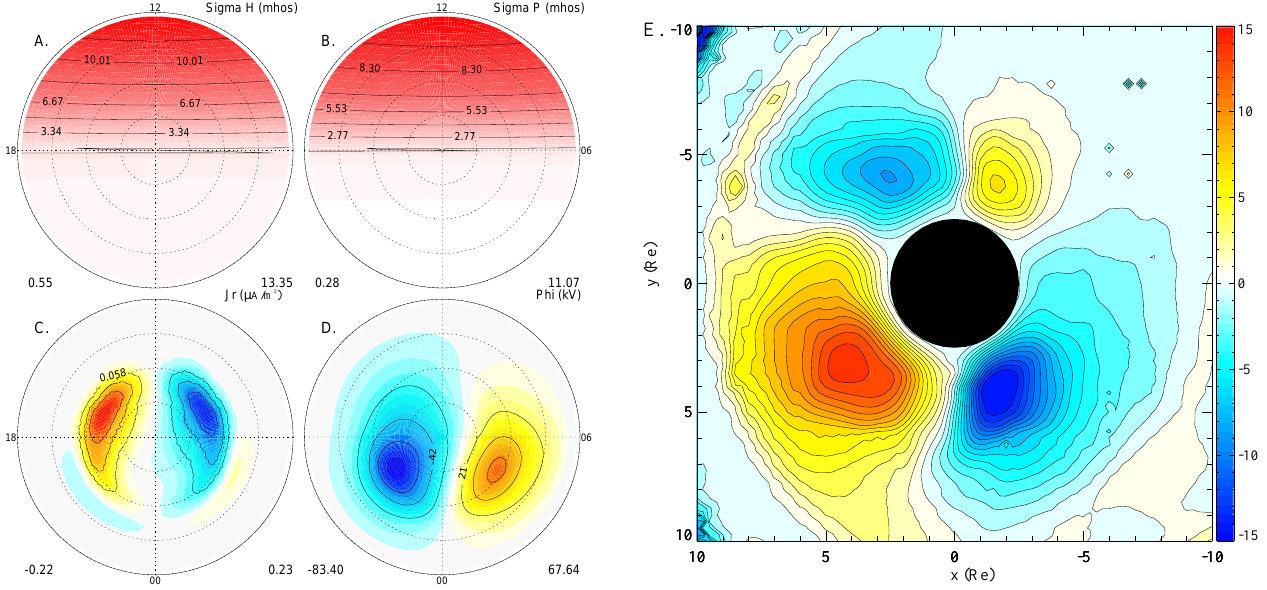
Plate 6. An ionospheric projection of the (A) Hall conductance, (B) Pedersen conductance, (C) FAC, and (D) potential, as shown in Plate 1, as well as (E) a plot of the percentage difference in pressure in the inner magnetosphere between a simulation with and without solar derived Hall conductance in the